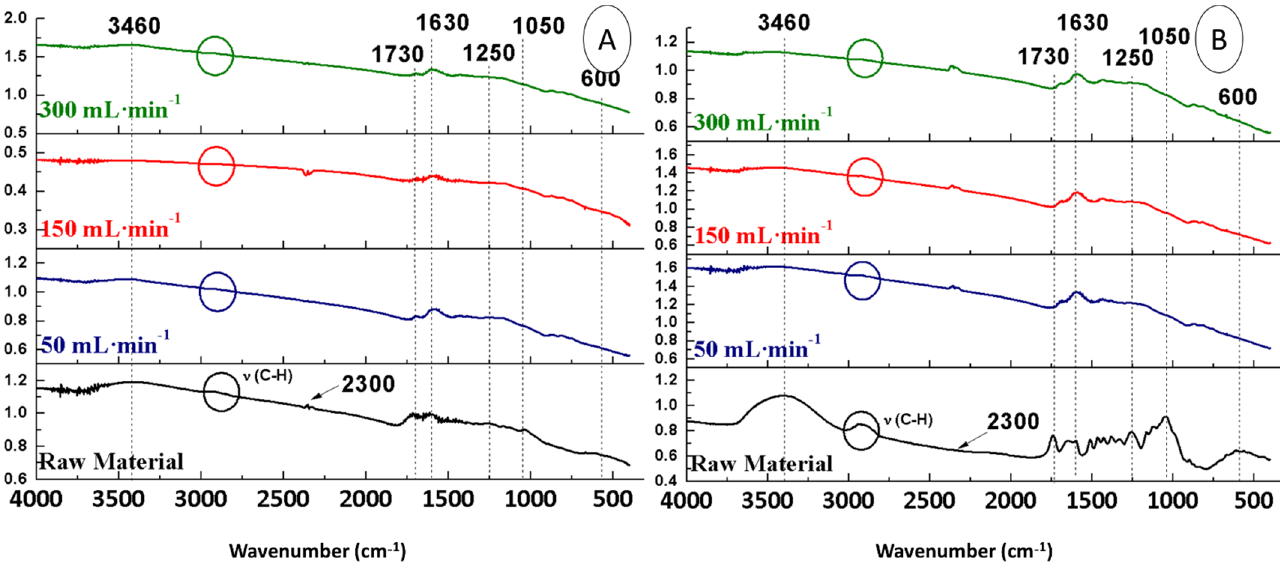
Figure 5. FTIR spectra of biochars from OS + H 2 SO 4 ( A ) and OS ( B ) at different Ar flows.